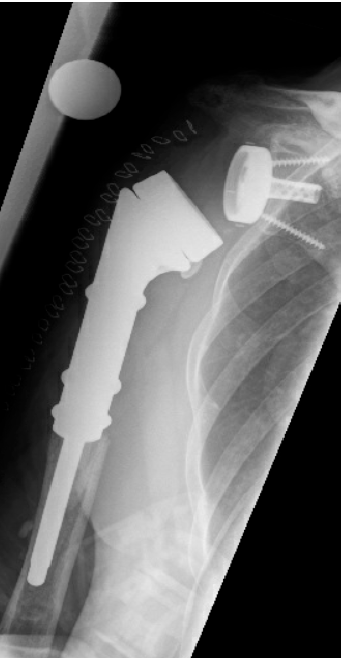
Figure 4. Postoperative anterior–posterior X-ray imaging of a right shoulder after prosthesis reim- plantation of reverse proximal humeral replacement due to severe humeral defect.